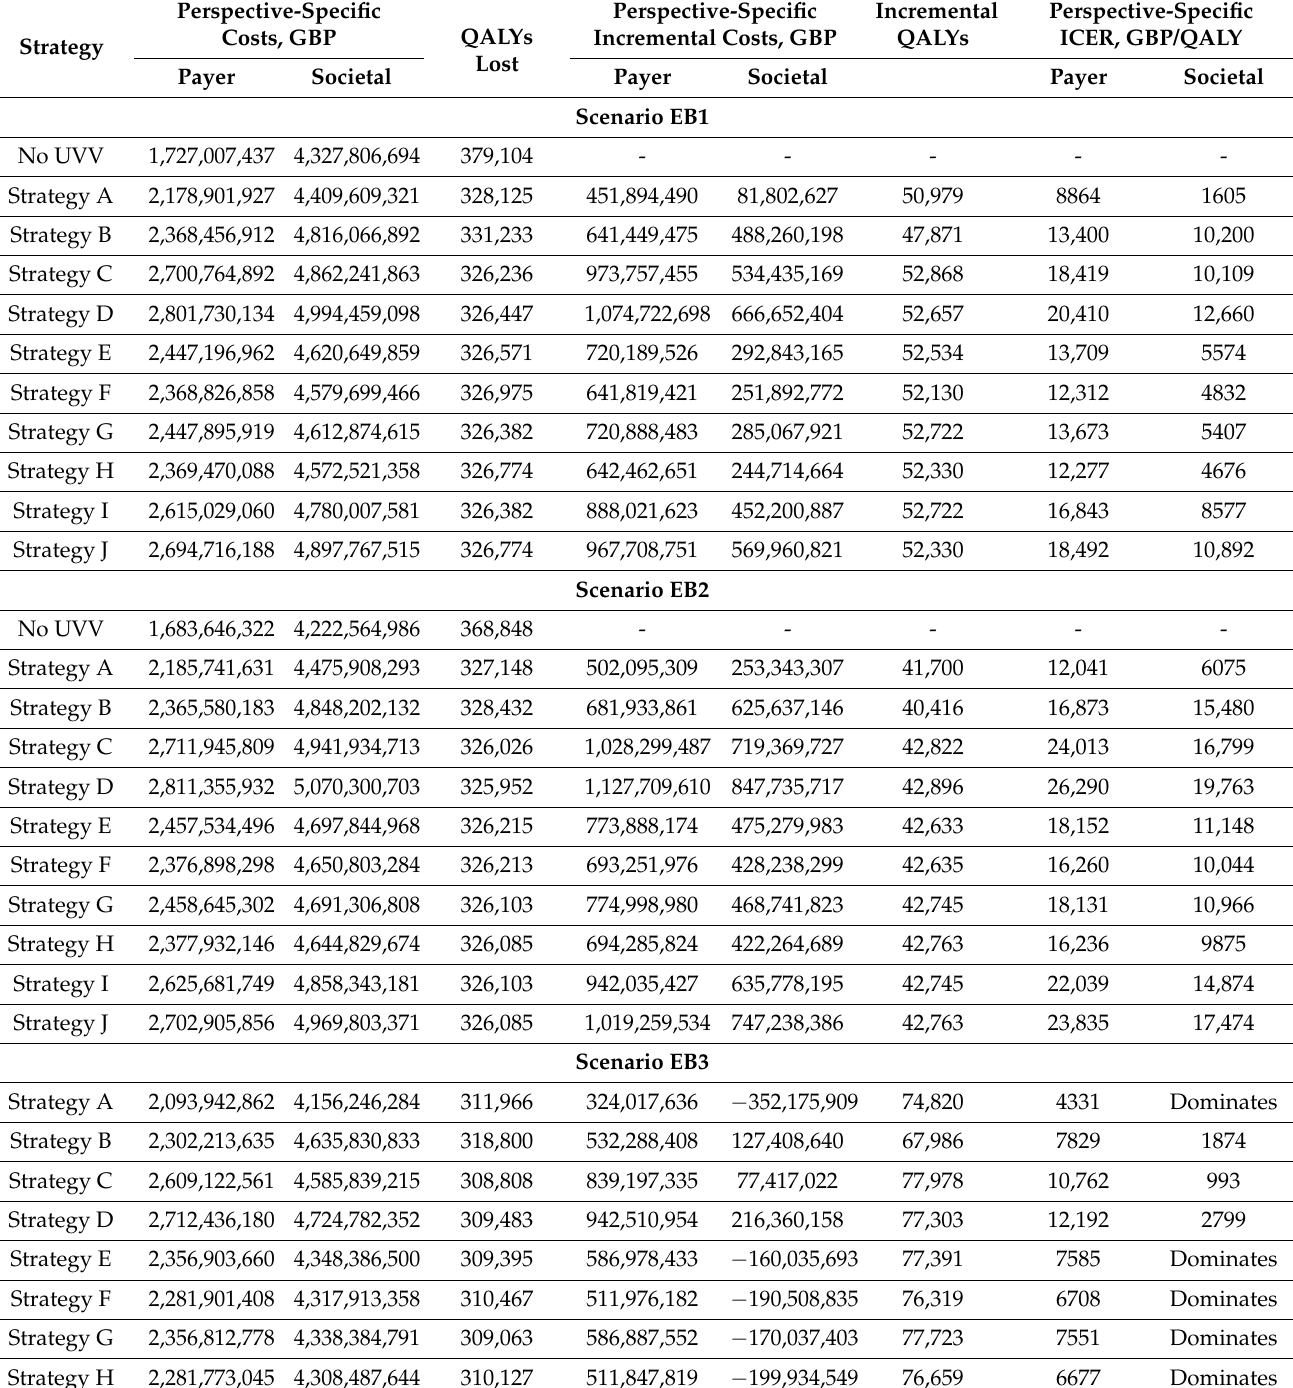
Table 3. Scenario analysis for the cost-effectiveness of alternative UVV strategies by perspective